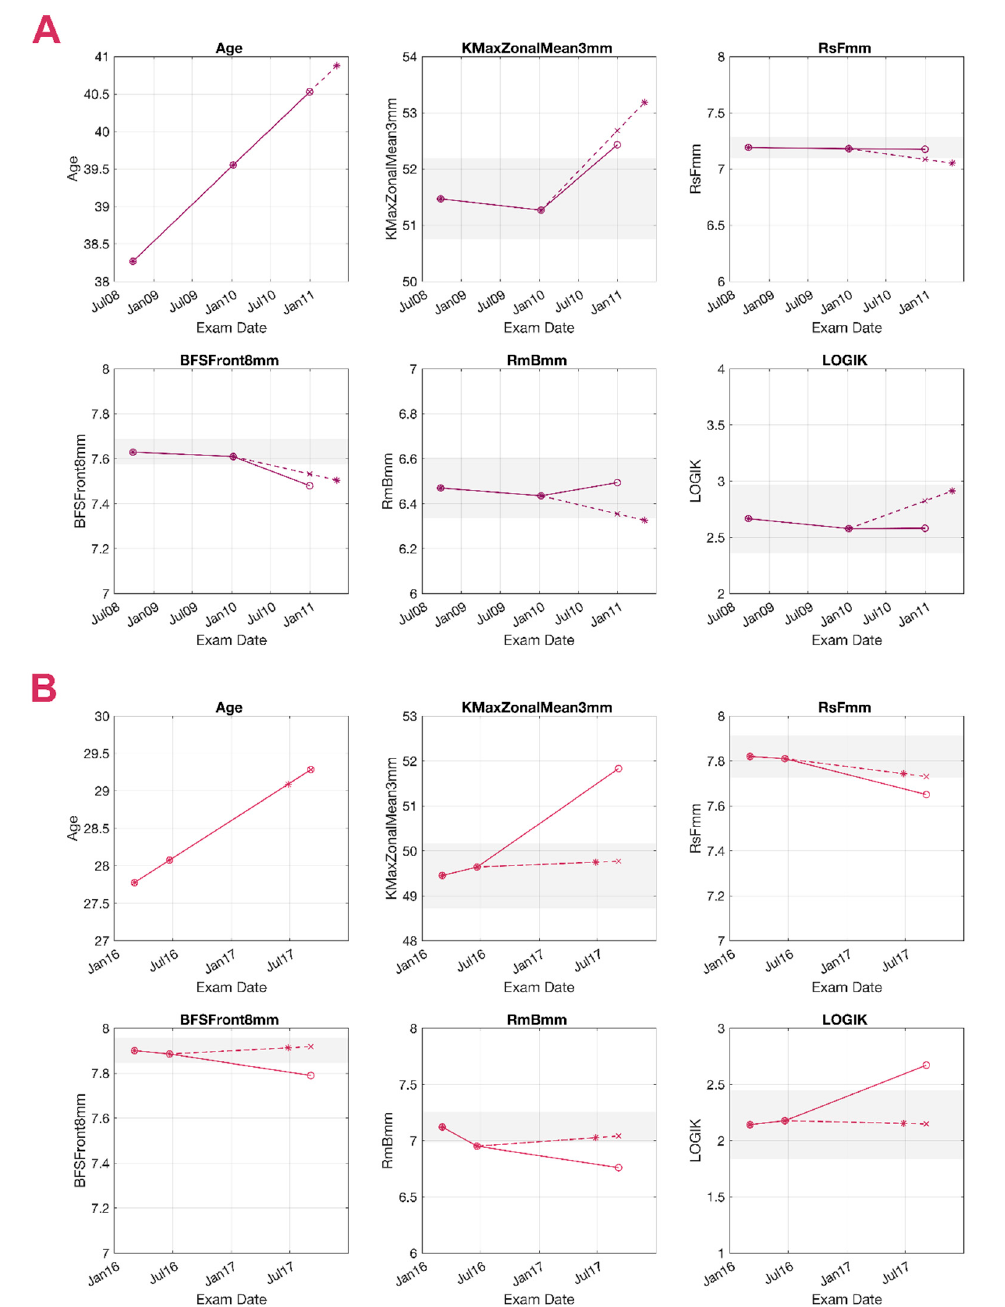
Figure 5. Prediction of a true-positive (TP) and a false-negative (FN) case. Grey areas represent the 95% confidence interval (95 CI) around the baseline value. Circles (o) represent the measured values in 3 consecutive examinations, and the asterisk ( ∗ ) represents the output of the system. The cross (×) is calculated by linear interpolation and aligned to the 2nd follow-up date. Continuous lines represent the measured trend, and the dashed lines represent the predicted trend. Measurements within the 95 CI are presented with the noise reduction applied. ( A ) TP, 38 years old. Significant change was found in the average keratometry in a 3 mm area around the maximum curvature point (KmaxZonalMean3mm) and the best fit sphere (BFS) in both the prediction and the real values. ( B ) FN, 27 years old. Although all 5 variables presented significant change, the system classified the eye as stable (none of the predicted variables reached the 95 CI). BFSF: best fit sphere of the front surface considering an 8 mm area, RmB: average radius of the back surface in mm, RsF: steepest radius of the front surface in mm.